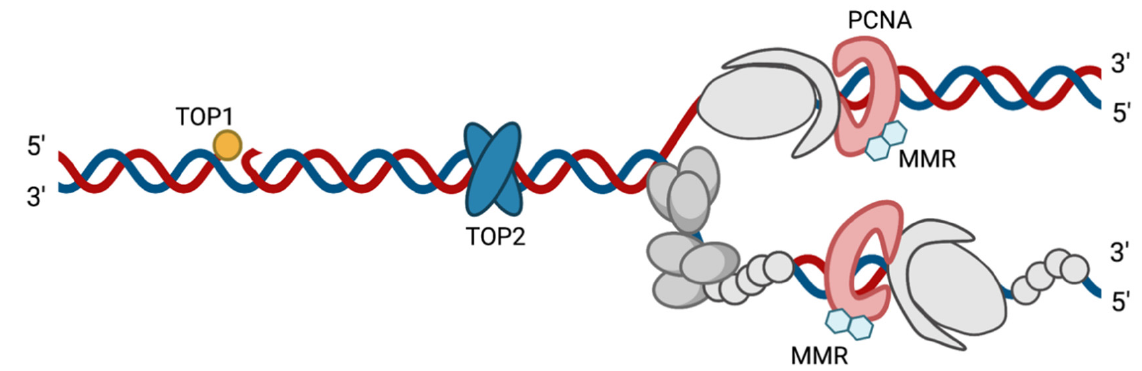
Figure 3. Schematic of cellular factors associated at HSV-1 replication forks. Viral replication proteins are in gray. Cellular factors found at viral replication forks that are depicted in this figure include TOP1 (yellow), TOP2 (blue), PCNA (red), and mismatch repair proteins (MMR) (light blue). Created with BioRender.com, accessed on 28 September 2021. Adapted from Dembowski, Dremel, and DeLuca PLoS Pathogens 2017 [15].